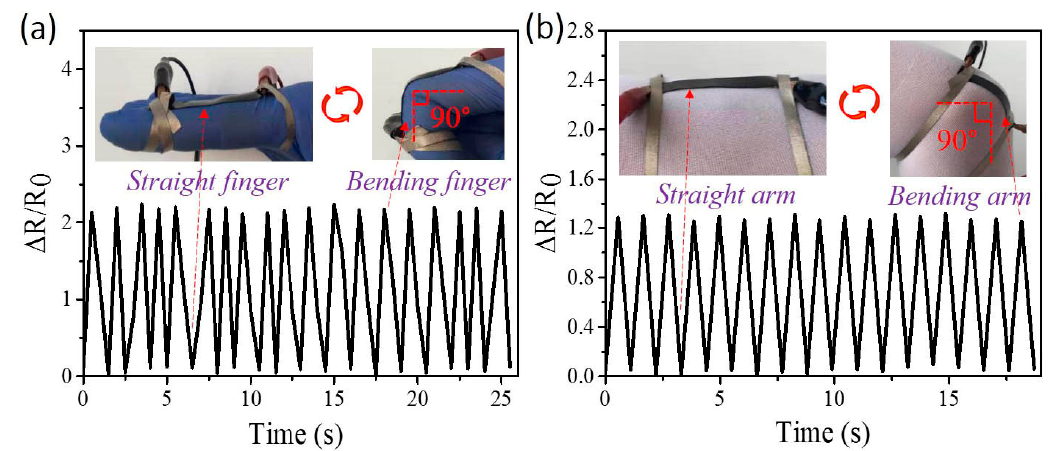
Figure 8. Human motion monitoring using the as-fabricated sensor, ( a ) relative resistance variations ( ∆ R / R 0 ) versus time for blending and release of the index finger, inset: snapshots of one bending cycle. ( b ) ∆ R / R 0 for TPU / CNF-C / CNTs strain sensors according to bending motions, inset: one bending cycle of arm, the bending motion degree of the arm at angle of 90 ◦.